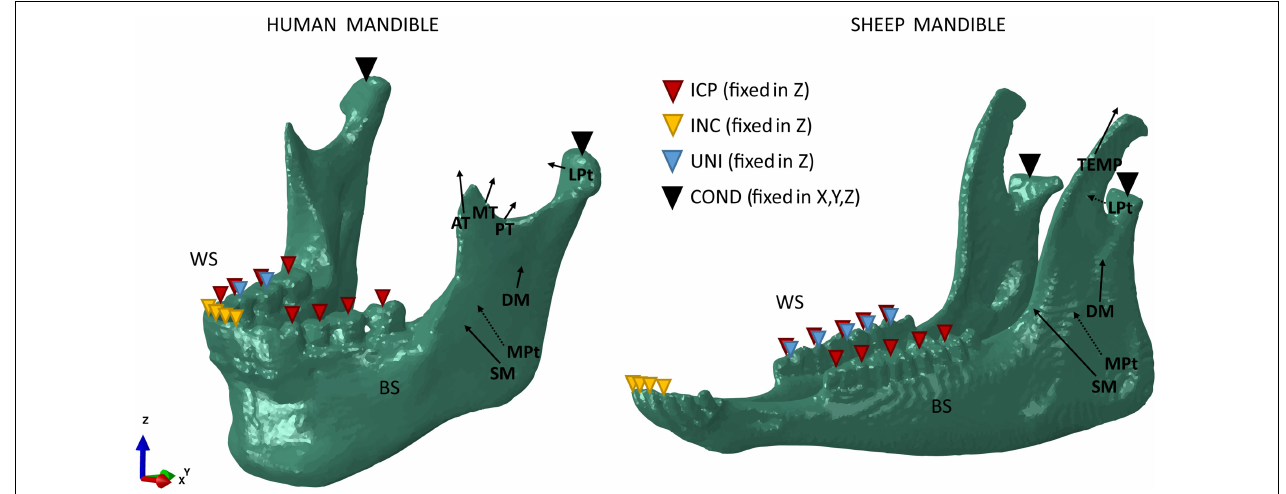
FIGURE 1 | Loading and boundary conditions for the human (left) and sheep (right) mandibles during intercuspal (ICP), incisal (INC), and unilateral (UNI) clenching. Bite force was simulated restraining the vertical displacement at the occlusion and both the human condyles and the sheep condylar processes (COND) in the 6 degrees of freedom. During UNI clenching, the right mandibular body is considered as the working side (WS) and the left mandibular body as the balancing side (BS).